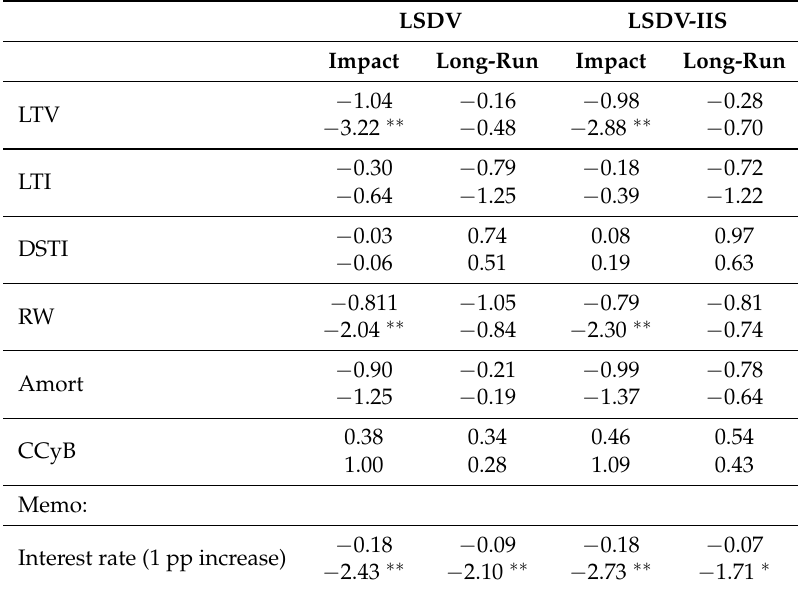
Table 3. House price change. Estimated (LSDV and LSDV-IIS) effects for LTV, LTI, DSTI, RW, Amort and CCyB. Results for the central bank rate shown in the memo part of the table. t-values are shown below the estimated impact and long-run effects. Statistical significance (two sided test) is indicated by ∗∗ (5% level) and ∗ (10%